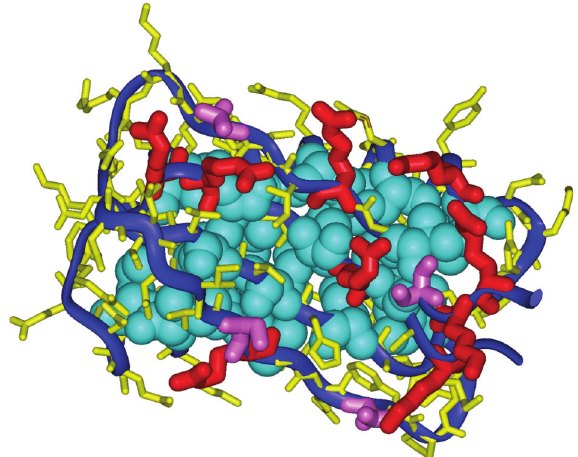
Figure 5: The little finger domain of Dpo4, showing amino acids whose R-groups contribute to the hydrophobic core (H1–H21, turquoise). Furthermore, lysine/arginine/asparagine/glutamine residues that interact with phosphate-oxygens are shown in red (L1–L9), and serine/threonine residues that interact with phosphate-oxygens are shown in pink (S1–S4). The view is toward the four anti-parallel β 1– β 4 strands, and β 1 begins to the right, while the last amino acid in β 4 is shown just below it. The view is also into the face that binds duplex DNA, where the helix axis is approximately vertical. The Dpo4 coordinates are from 1SOM-B.